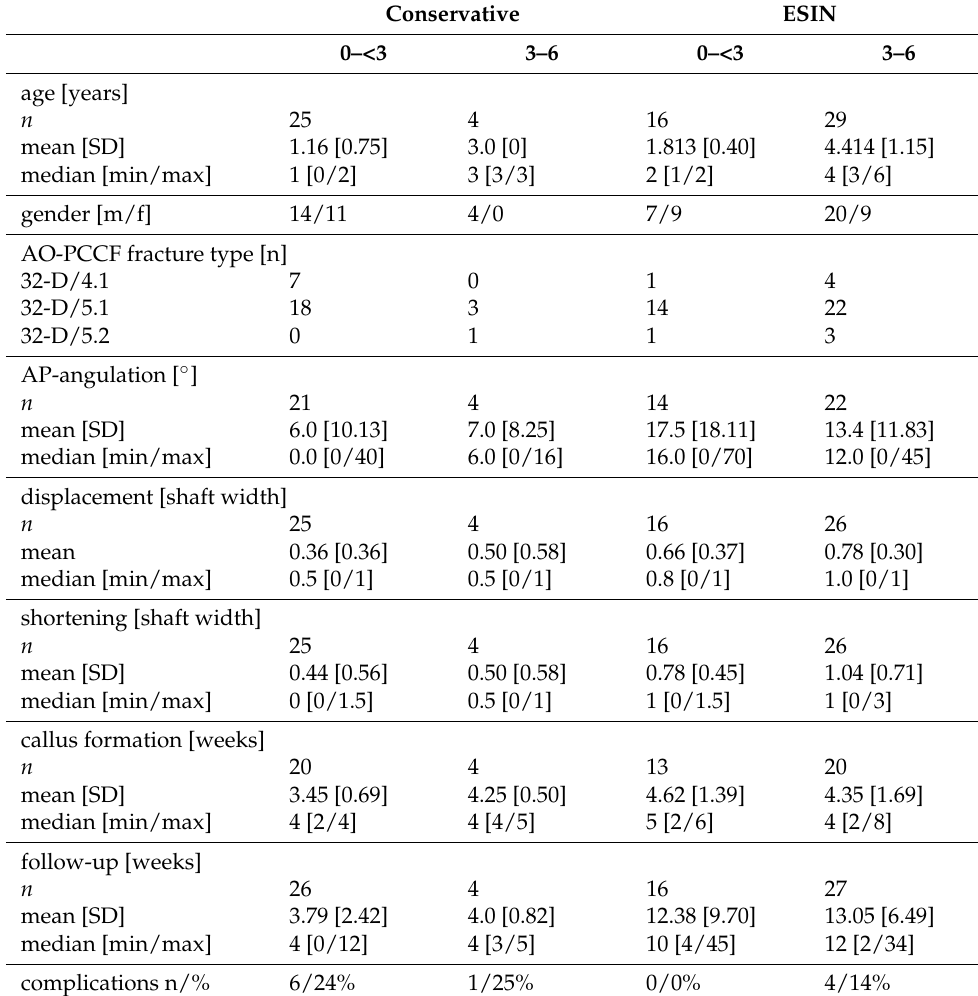
Table 3. Subgroup analysis of patients 6 years and younger. Anterior-posterior (AP), AO Pediatric Comprehensive Classification of Long-Bone Fractures (AO-PCCF), standard deviation (SD), male (m) and female (f), number of patients ( n